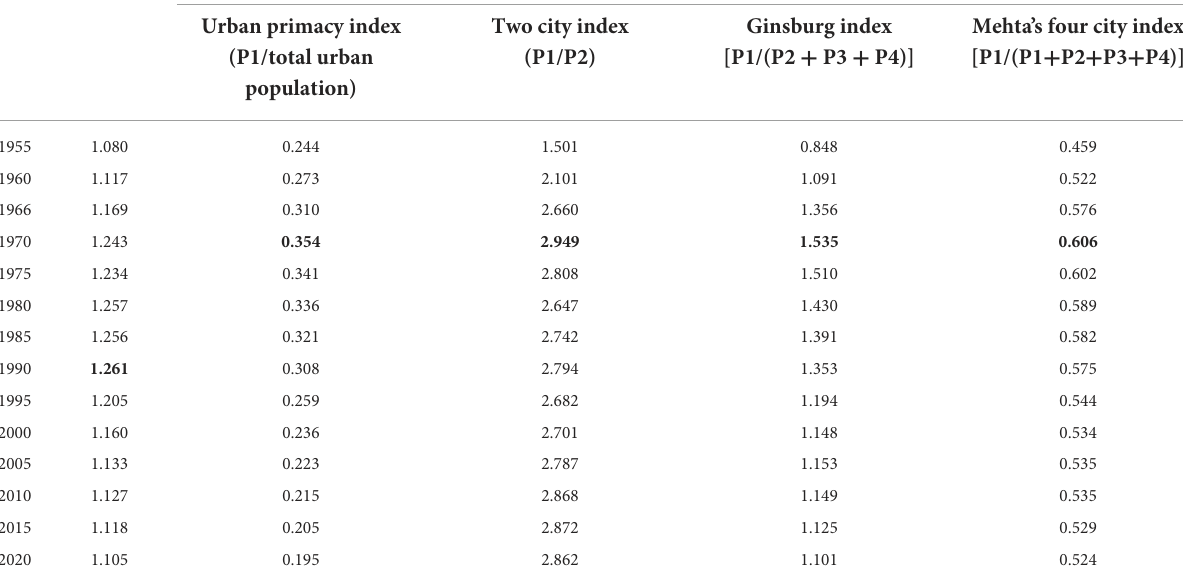
TABLE 1 Changes in q coefficients and urban primacy indices (city